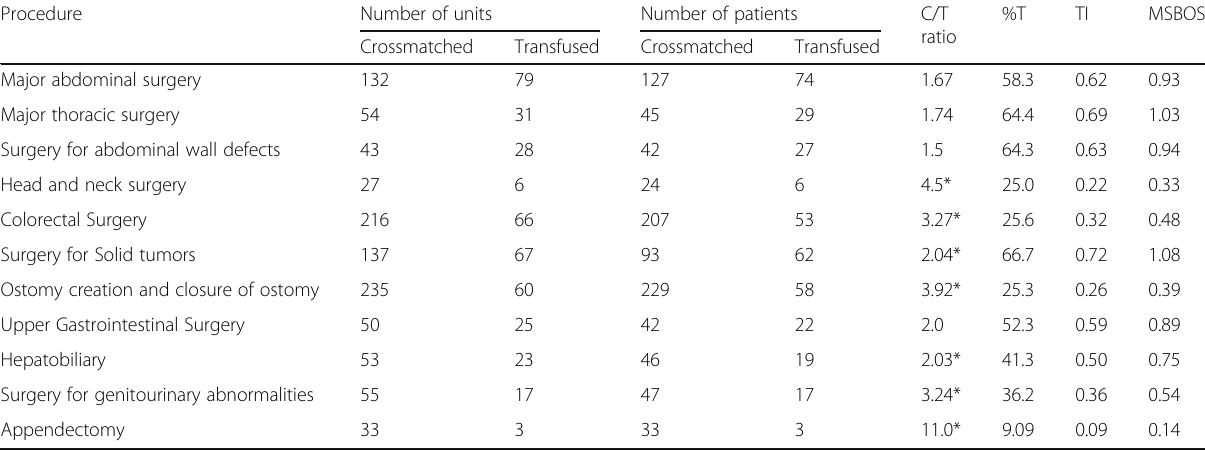
Table 2 Blood utilization indices among pediatric surgical patients in the Philippine Children ’ s Medical Center